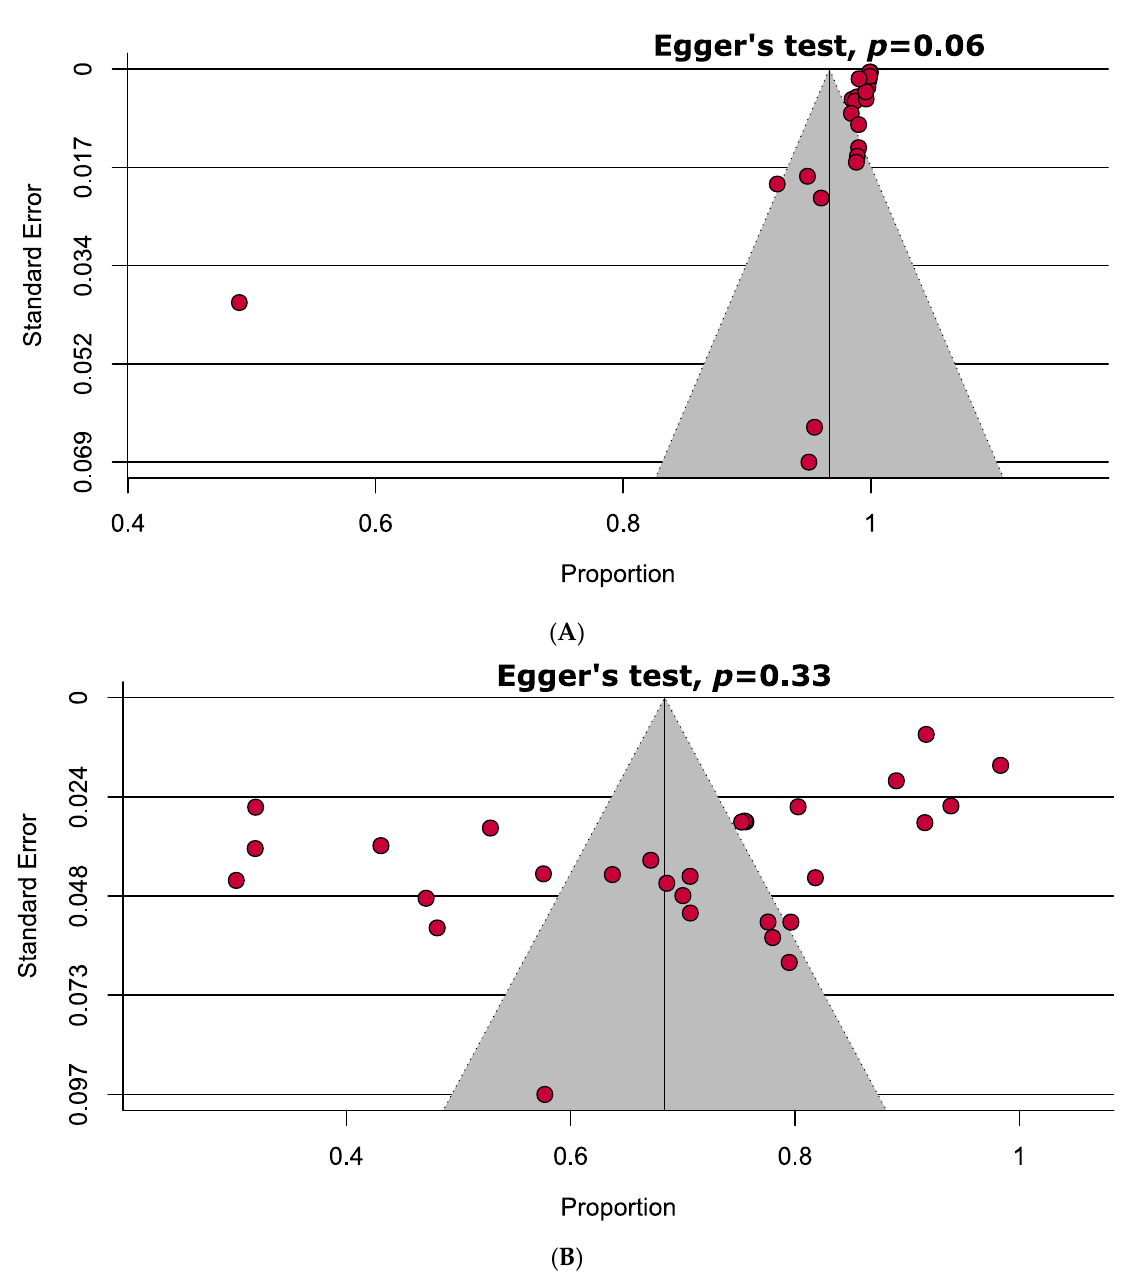
Figure 2. Funnel plots representing no evidence of significant publication bias estimating ( A ) specificity and ( B ) sensitivity of rapid antigen tests in confirming COVID-19.